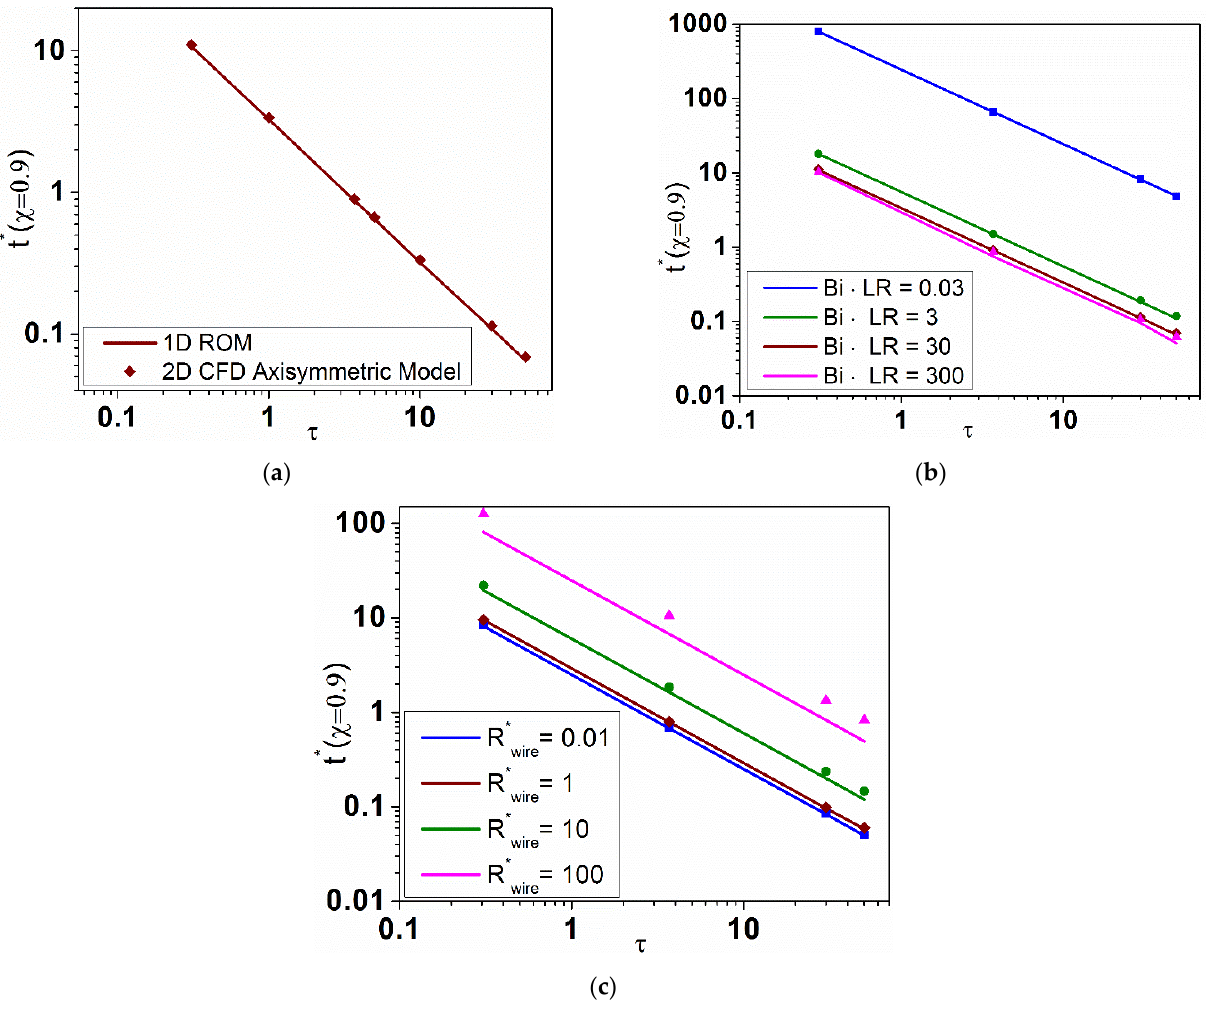
Figure 13. Effect of dimensional parameters: ( a ) τ , ( b ) Bi · LR , and ( c ) R ∗ parameter t ∗ ( χ = 0.9 ) , where continuous lines represent 1D ROM while discrete points represent the 2D CFD axisymmetric